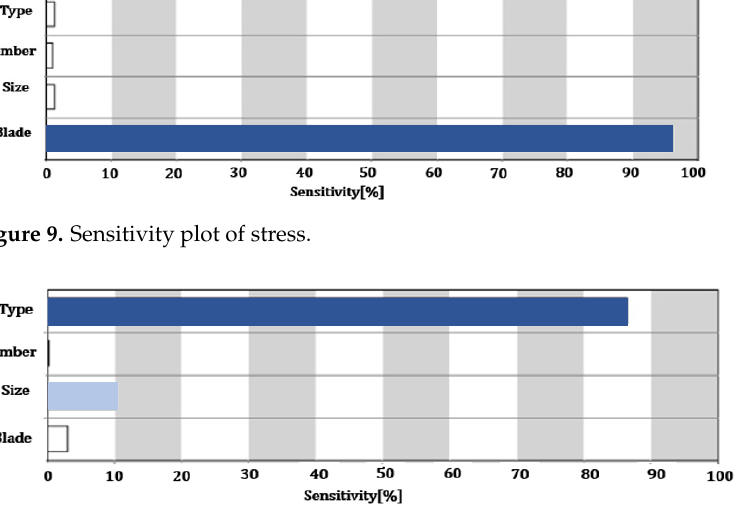
Figure 10. Sensitivity plot of temperature.